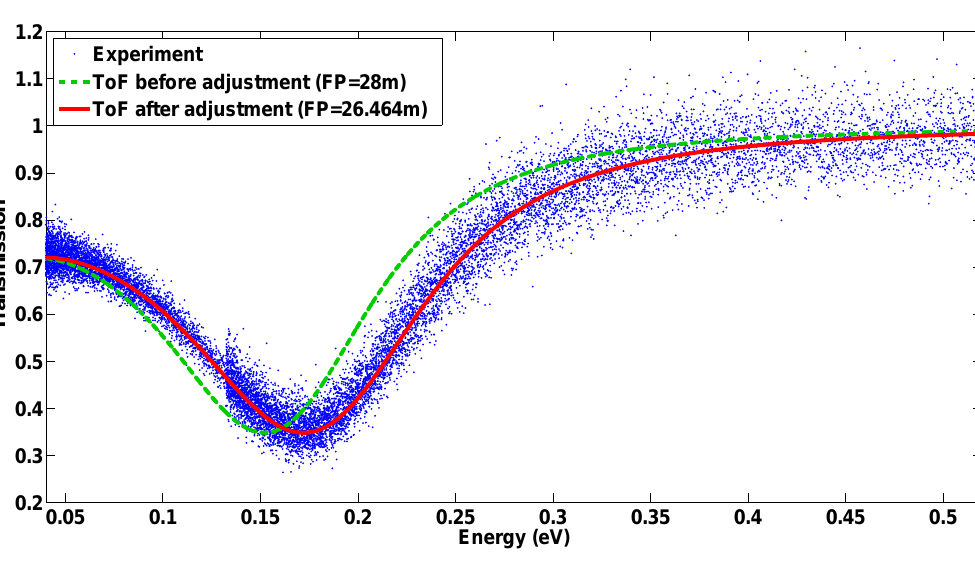
Figure 1. 113 Cd transmissions before and after adjustement of the flight path